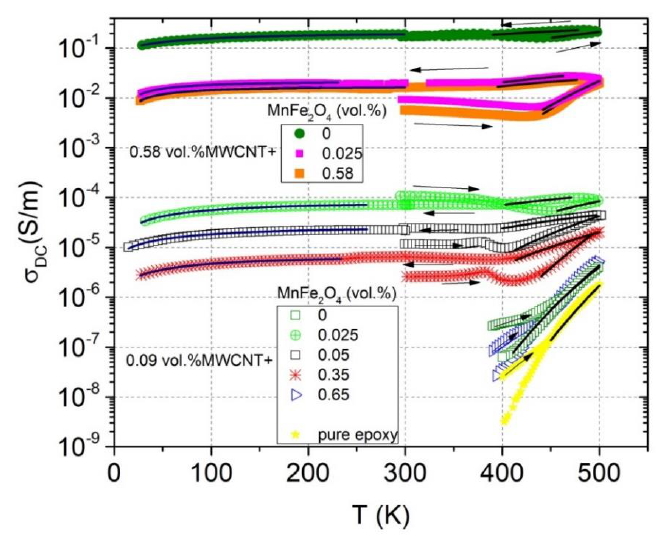
Figure 5. Temperature dependence of the DC conductivity. Solid lines at high and low temperatures correspond to approximations according to Equations (1) and (2), respectively.